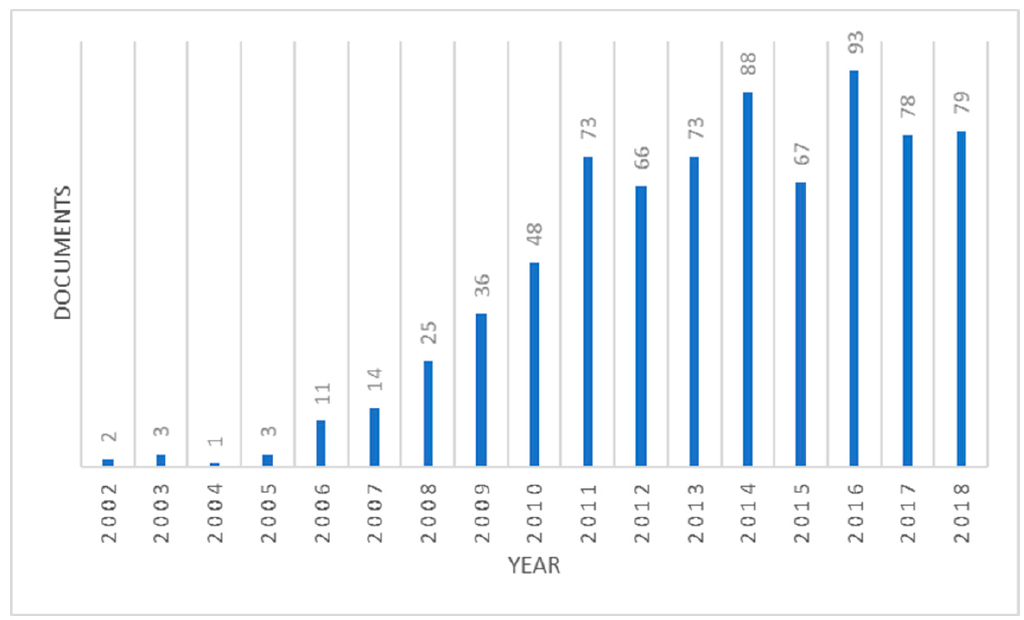
Figure 1. Trend of the peer review manuscripts per year which contain “glycerol reforming” in abstract, keywords, and title. Adapted from Scopus ® [24].